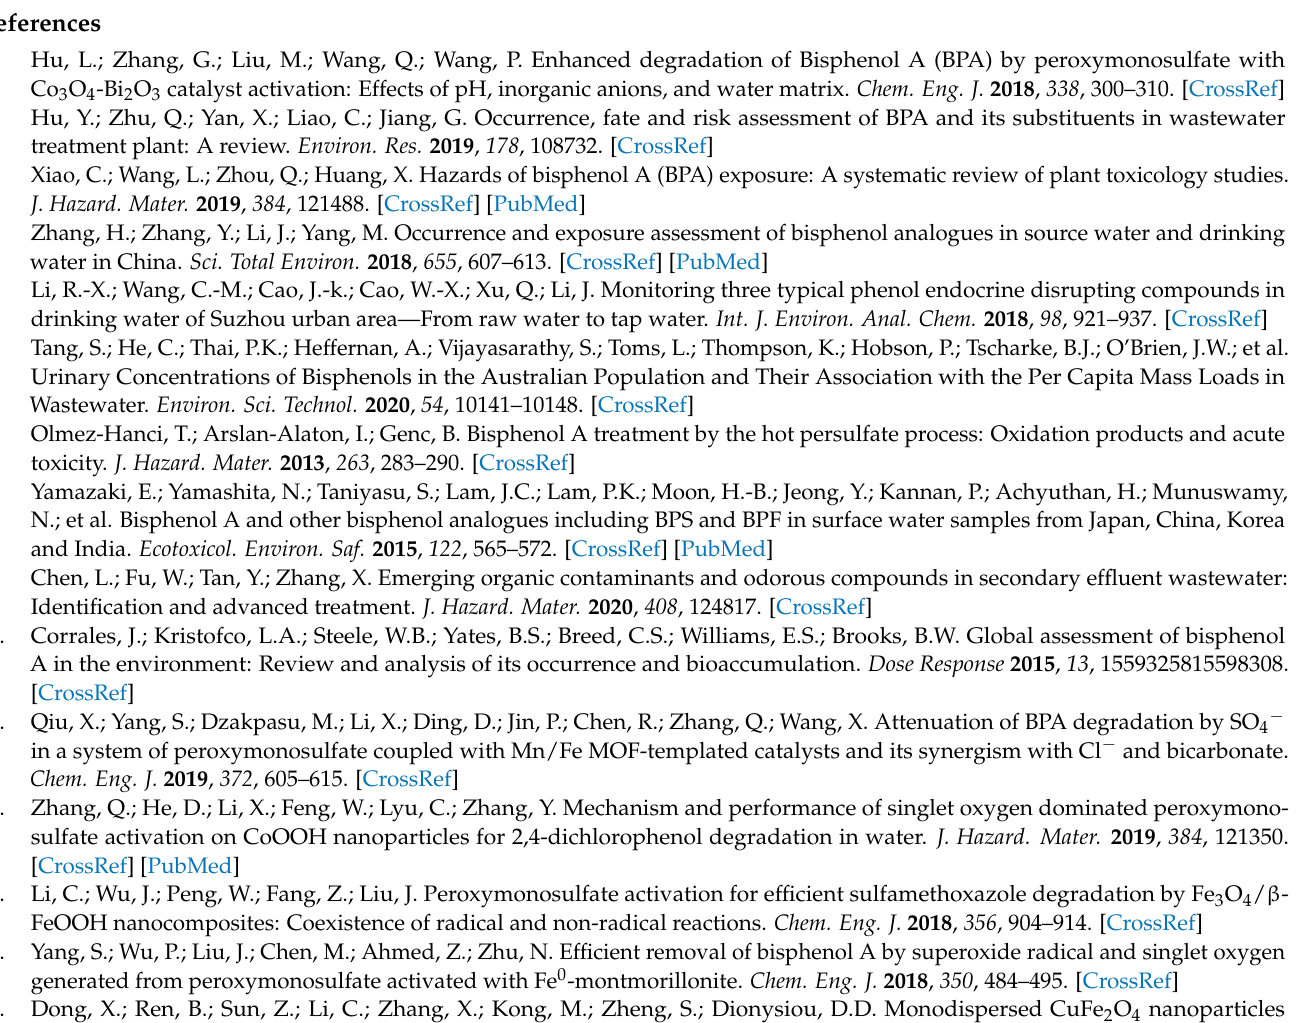
Figure S7: Changes in toxicity with reaction time in the Mn 2 O 3 /PMS system. Reaction conditions: [BPA] 0 = 10 mg/L, [PMS] 0 = 0.10 mM, [Mn 2 O 3 ] 0 = 0.2 g/L, initial pH = 7.00, Figure S8: TOC removal of BPA by the Mn 2 O 3 /PMS system. Reaction conditions: [BPA] 0 = 10 mg/L, [PMS] 0 = 0.10 mM, [Mn 2 O 3 ] 0 = 0.2 g/L, initial pH = 7.00, Figure S9: XRD spectra of the fresh and used commercial Mn 2 O 3 . Table S1: Water quality parameters of real water, Table S2: Main TPs of BPA identified by ESI analysis, Table S3: Identified main TPs of BPA by ESI